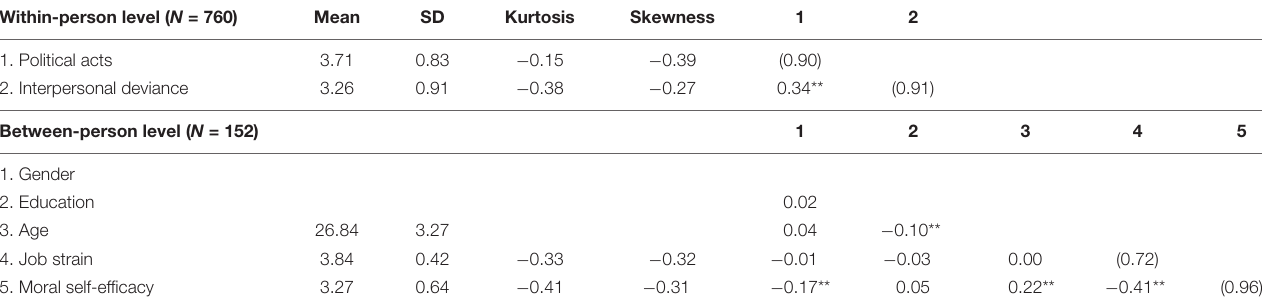
TABLE 1 | Means, standard division, and correlation analysis.